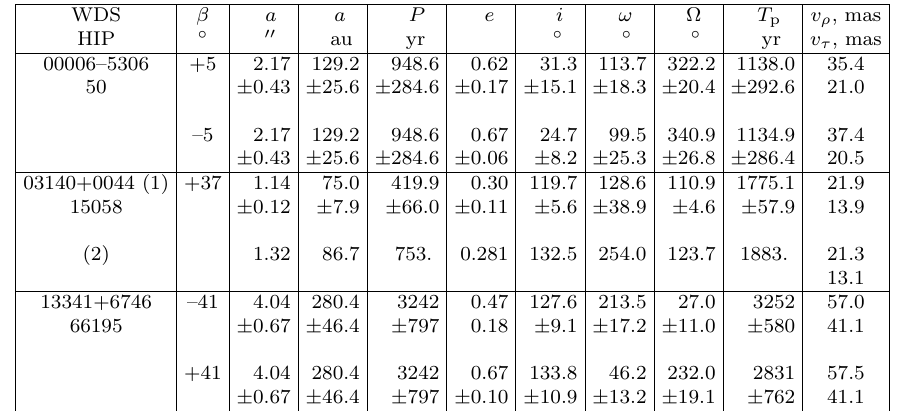
Table 5. Orbital